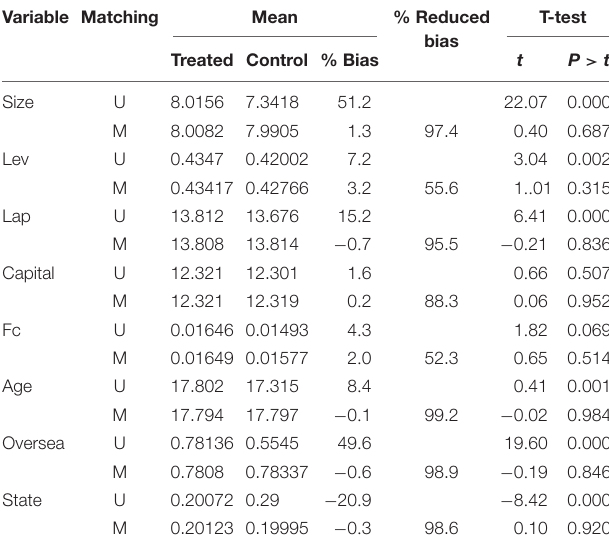
TABLE 4 | Results of equilibrium test using the PSM method. Variable Matching